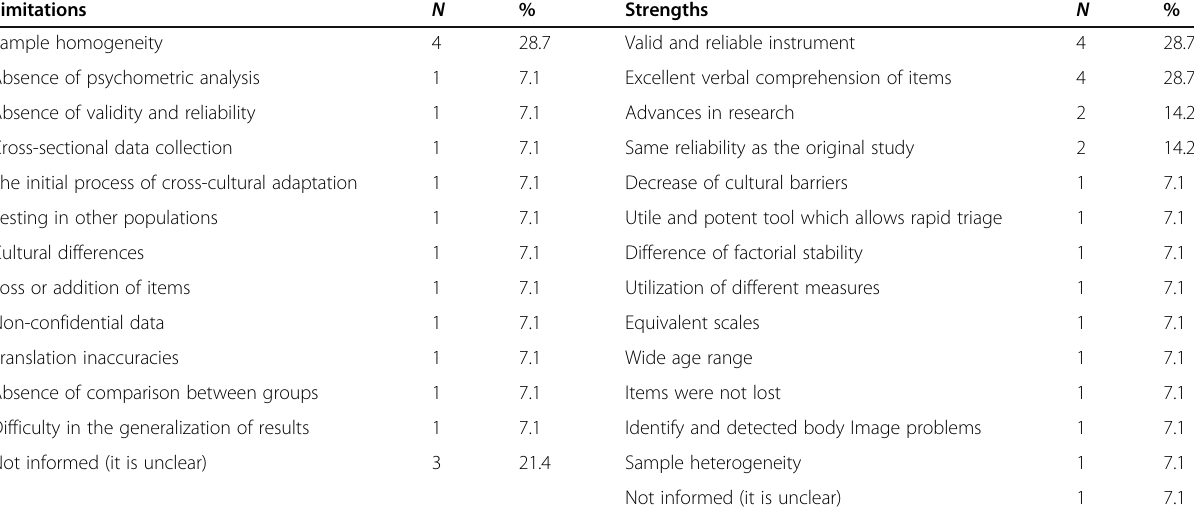
Table 4 Distribution of limitations and strengths reported in the studies included in this systematic review